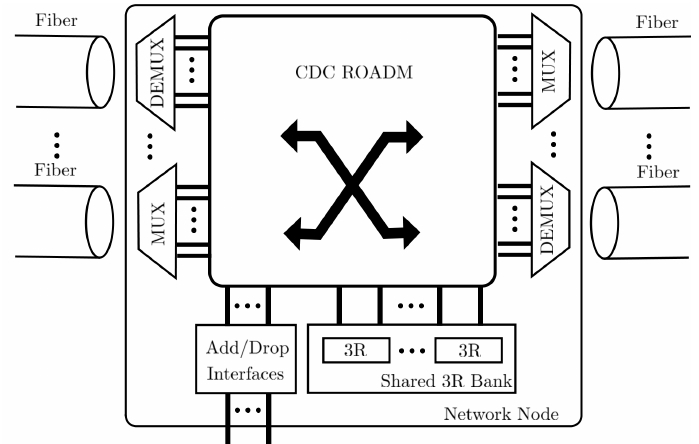
Figure 1. Node architecture assumed in this paper composed by a colorless/directionless/ contention- less (CDC) ROADM, de/multiplexers, add/drop interfaces, and a shared bank of 3R regenerators (adapted from